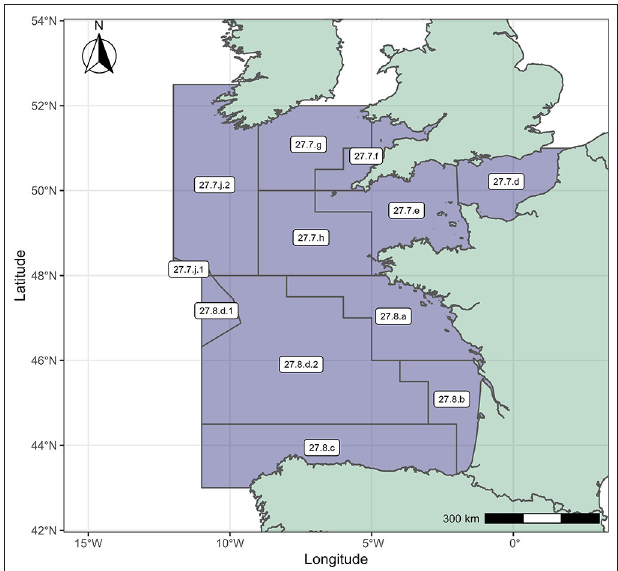
FIGURE 1 | Study area in the North-East Atlantic ocean, with ICES divisions